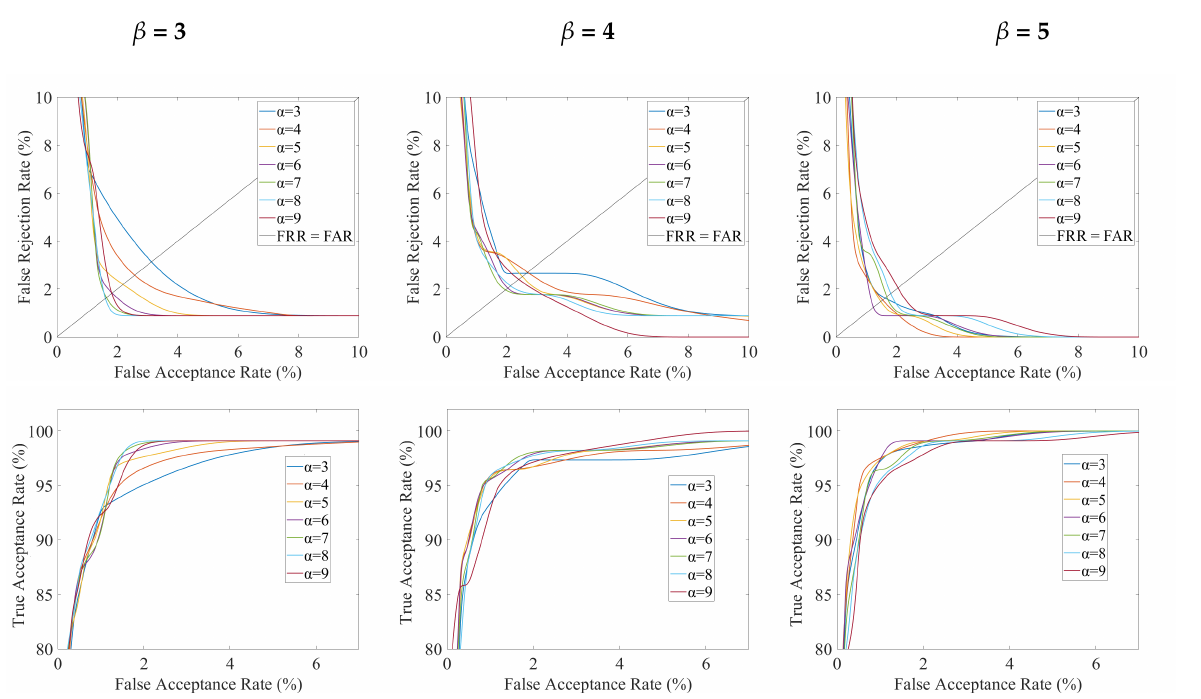
Figure 5. DET (first line) and ROC (second line) curves obtained with palmprint templates by varying α and β values. Table 2. 3D Hand Geometry: EER and AUC values for the three types of 3D templates.